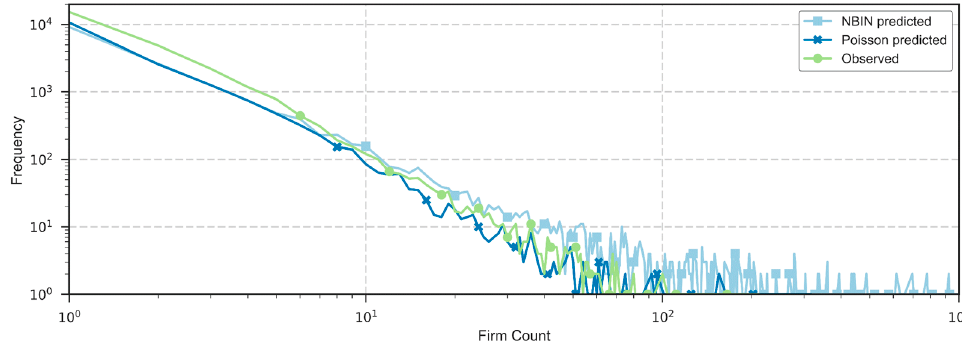
Figure 4. Frequencies of observed and predicted software firm counts. Figure 5 maps the regression residual (prediction error) aggregated on a regular 5 km grid.